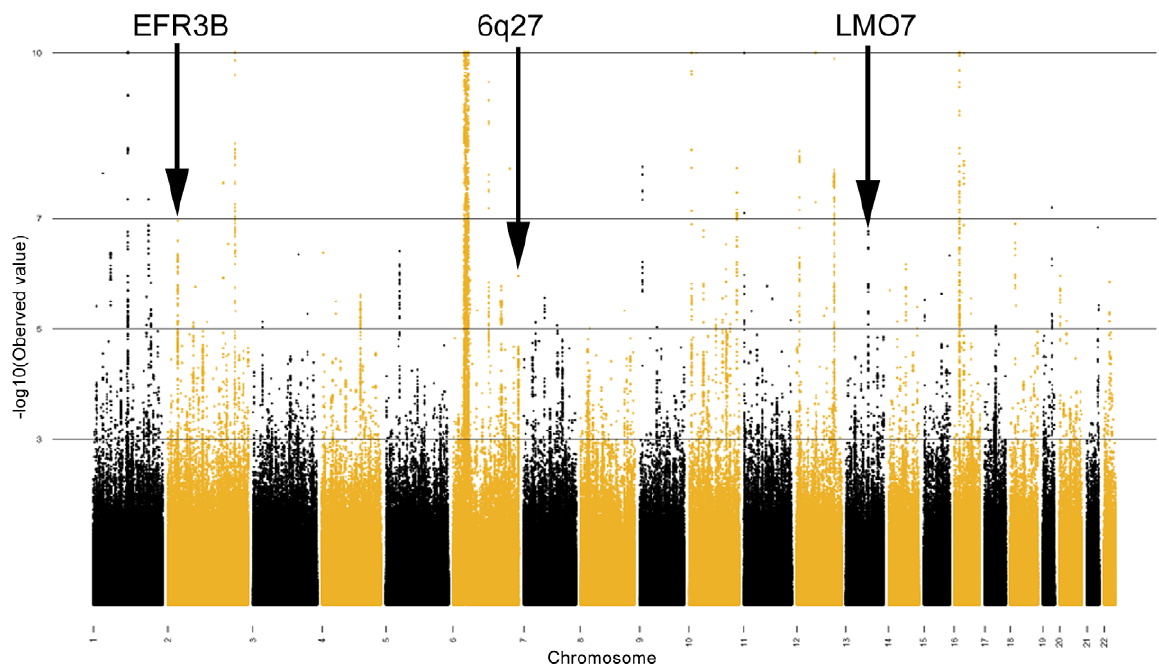
Figure 2. Fixed effects meta-analysis P -values shown for each SNP in the combined meta-analyzed discovery cohort. SNPs are sorted by chromosomal location. –log10( P -value) are shown, where the minimum P -value has been capped at 1 6 10 2 10 . Only the novel loci are indicated.